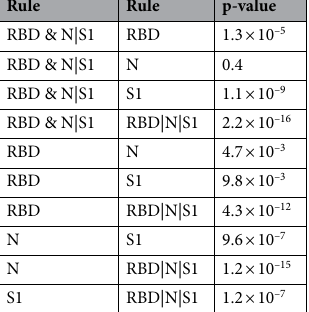
Table 5. p-values of the McNemar’s test to compare the agreement in positive/negative calls between rules for total antibody detection in the seroprevalence study. The cut-off of Mean + 5SD is used for each single and multi-antigen